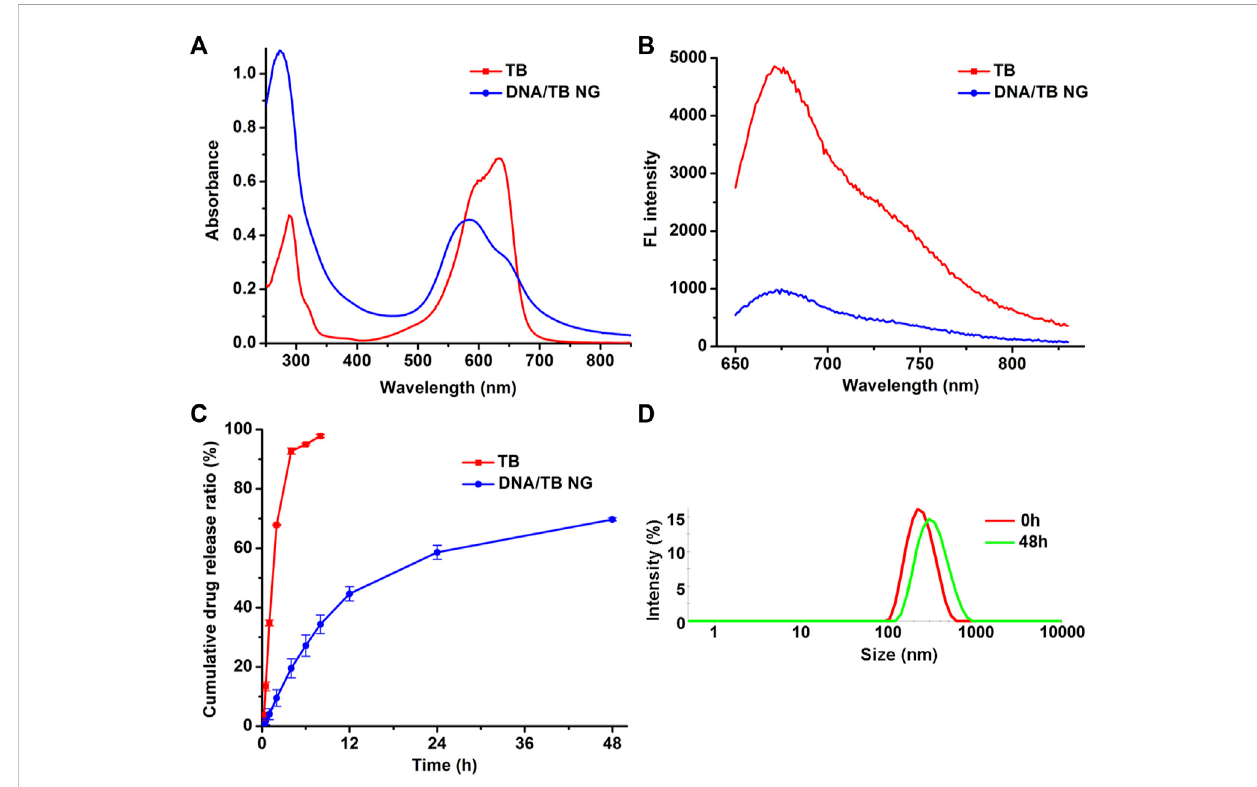
FIGURE 2 Spectra and drug release analysis of DNA/TB NG. (A) Absorption spectra and (B) fl uorescence spectra of free TB and DNA/TB NG. The TB concentration was fi xed at 20 μ g/mL. (C) Drug release of TB in PBS at 37 ° C. (D) Size distribution of DNA/TB NG dispersed in PBS for 2 days (37 °